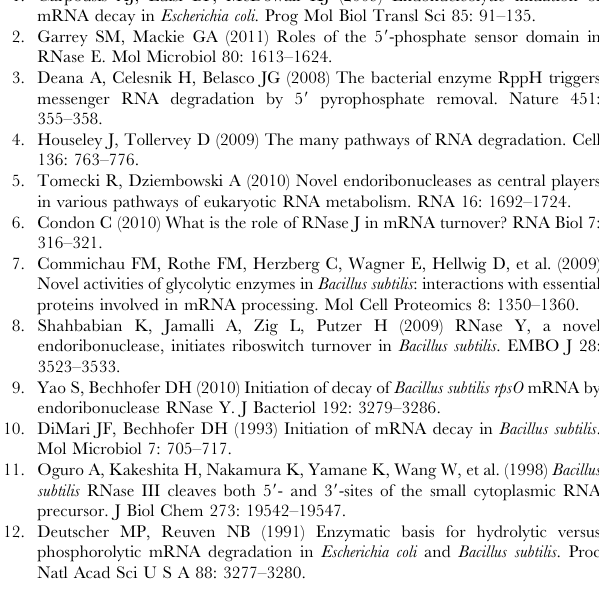
Table S6 Oligonucleotides used in this study. Hybridizing sequences in first PCR cycle are in upper case; non-hybridizing sequences are lower case. Table S7 Functional categories of genes showing altered expression in RNase mutants. Functional categories are from Subtiwiki v20110601, level 3 (http://subtiwiki.uni-goettingen.de/ wiki/index.php/Categories). The percentage of genes in each functional category showing significantly increased abundance (%Up), not significantly changed (%-), or significantly decreased abundance (%Down) is shown for each RNase. The p-value of the Fisher exact test for rejecting the null hypothesis of a distribution similar to that of the whole gene set is provided for each enzyme. Significant p-values (0.05 level after Bonferroni correction for